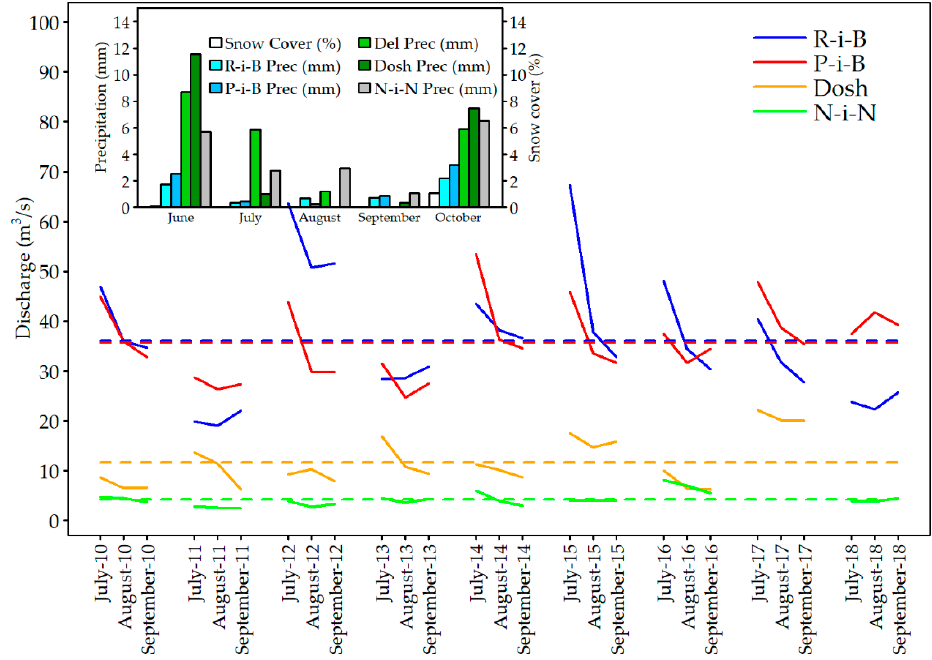
Figure 3. Historical monthly recorded discharge and precipitation in the BRB for hydrometeorological stations Rabat-i-Bala (R-i-B0, Pul-i-Baraq (P-i-B), Delmarogh (Del), Doshqadam (Dosh), and Nazdik-i-Nayak (N-i-N). The dotted line shows the average discharge. The monthly average snow cover over the BRB from MODIS snow cover product collection 6.